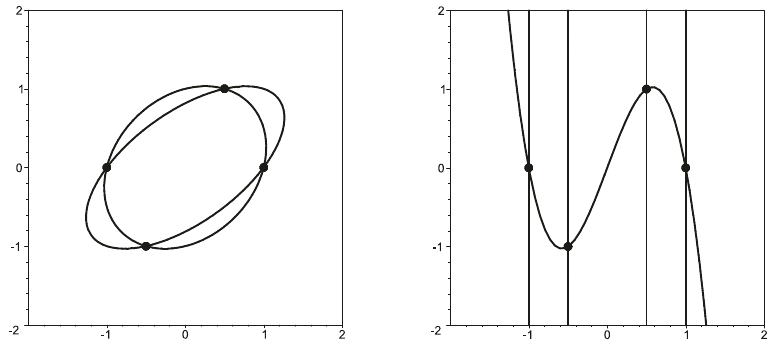
Figure 4 . Buchberger’s algorithm for the intersection of two